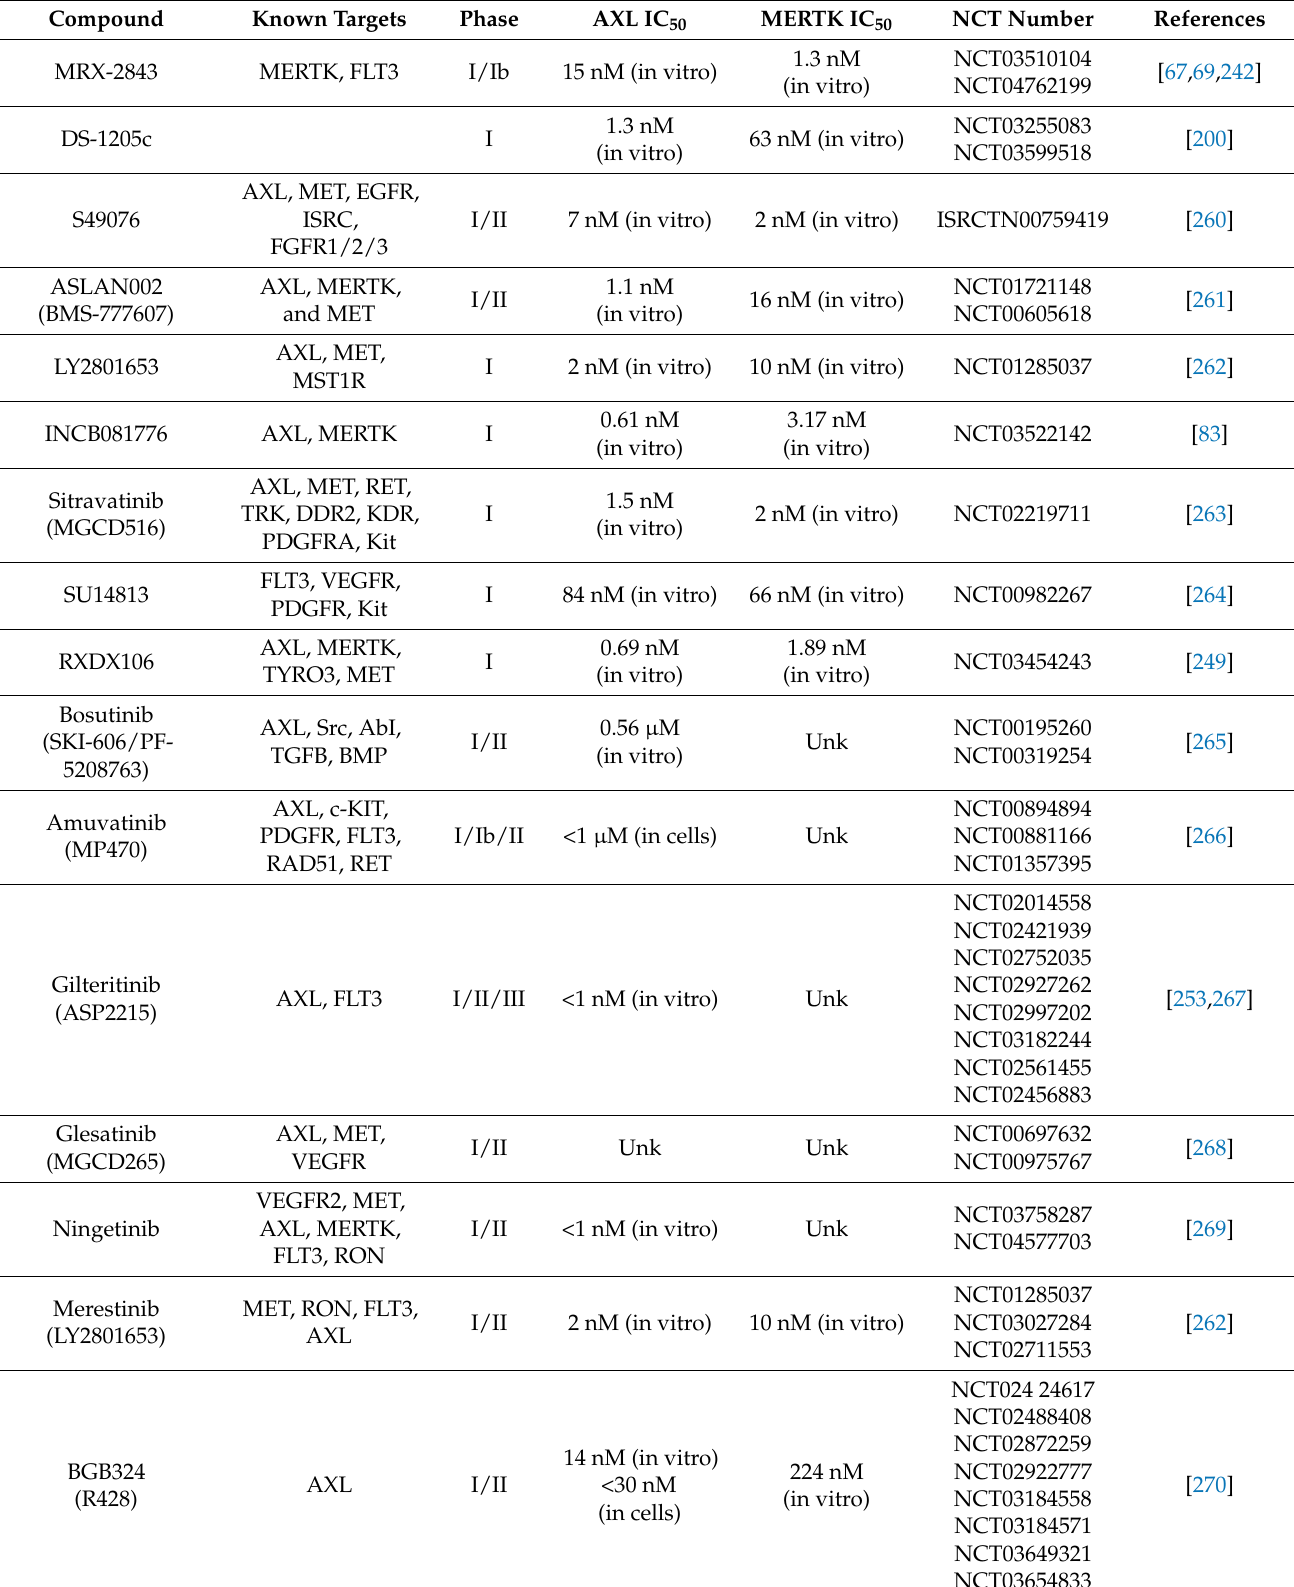
Table 3. Summary of small molecule MERTK/AXL kinase inhibitors in clinical